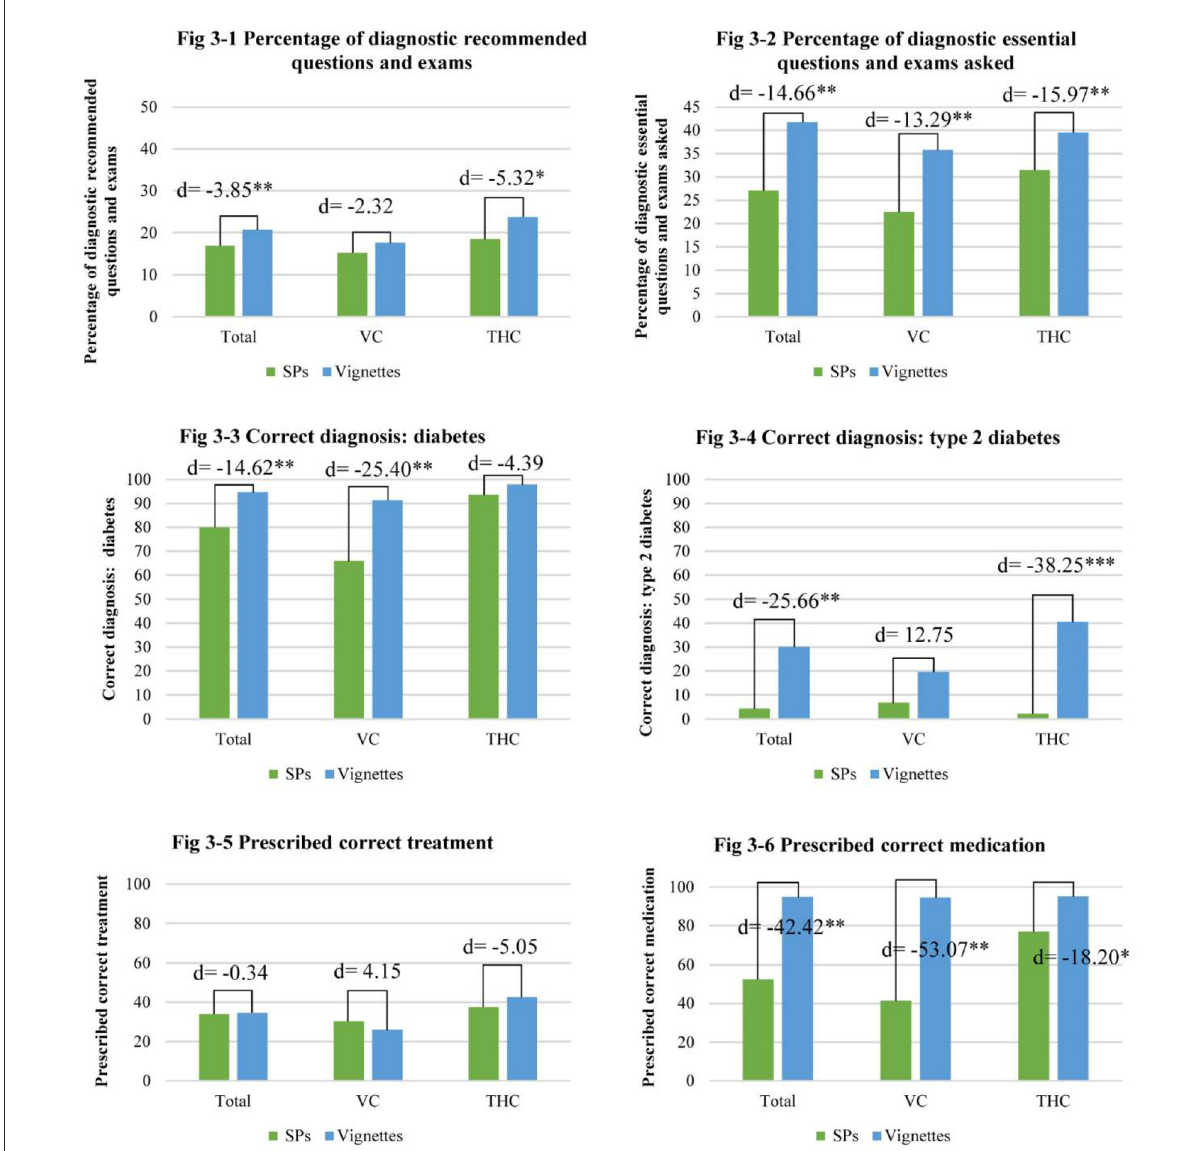
FIGURE3 The know-do gap of diagnostic questions asked and diagnosis and treatment given for diabetes cases (* p < 0.05, ** p < 0.01, *** p <